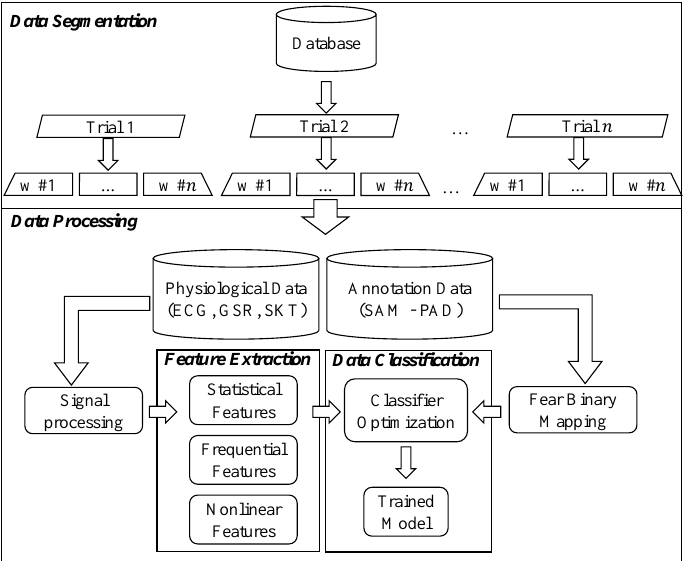
Figure 1. Overview of the proposed fear recognition system employing physiological sensor data and the pleasure, arousal and dominance (PAD) dimensional approach emotion labeling. The latter is fed into the fear binary mapping procedure. ECG: electrocardiogram; GSR: galvanic skin response; SKT: skin temperature; SAM: self-assessment